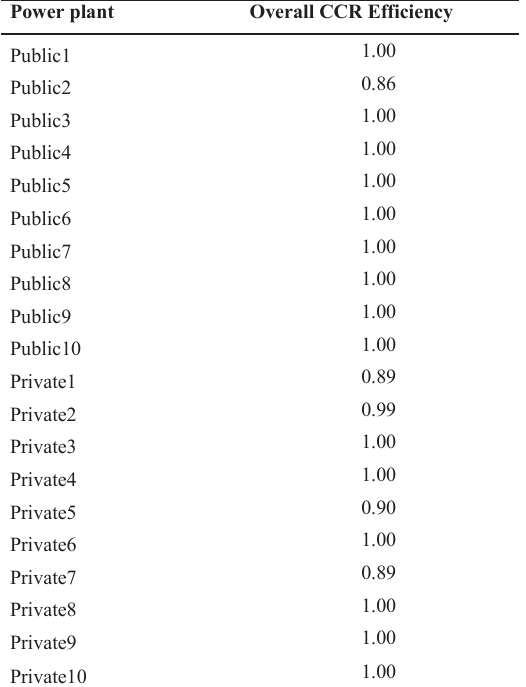
Table 5. Target Input Values for Inefficient Power Plants Power